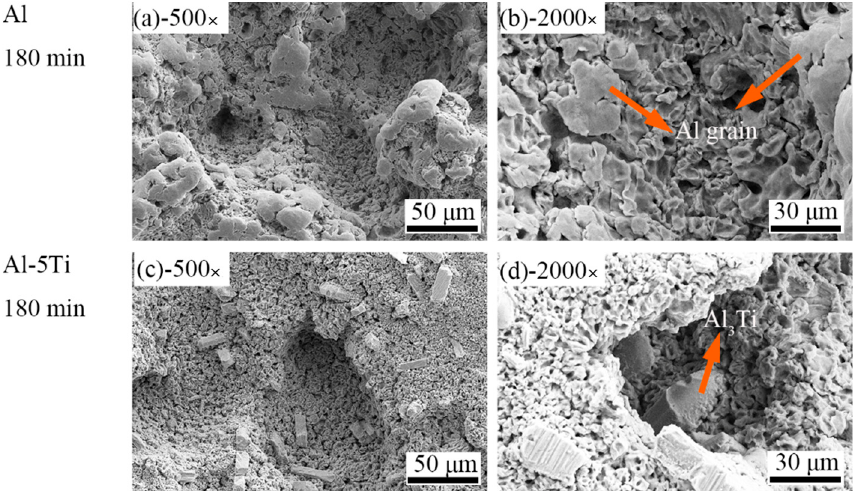
Figure 8. SEM images of different magnification of Al and Al-5Ti alloys after cavitation erosion for 180 min ( a ) 500× of Al, ( b ) 2000× of Al, ( c ) 500× of Al-5Ti, ( d ) 2000× of Al-5Ti.